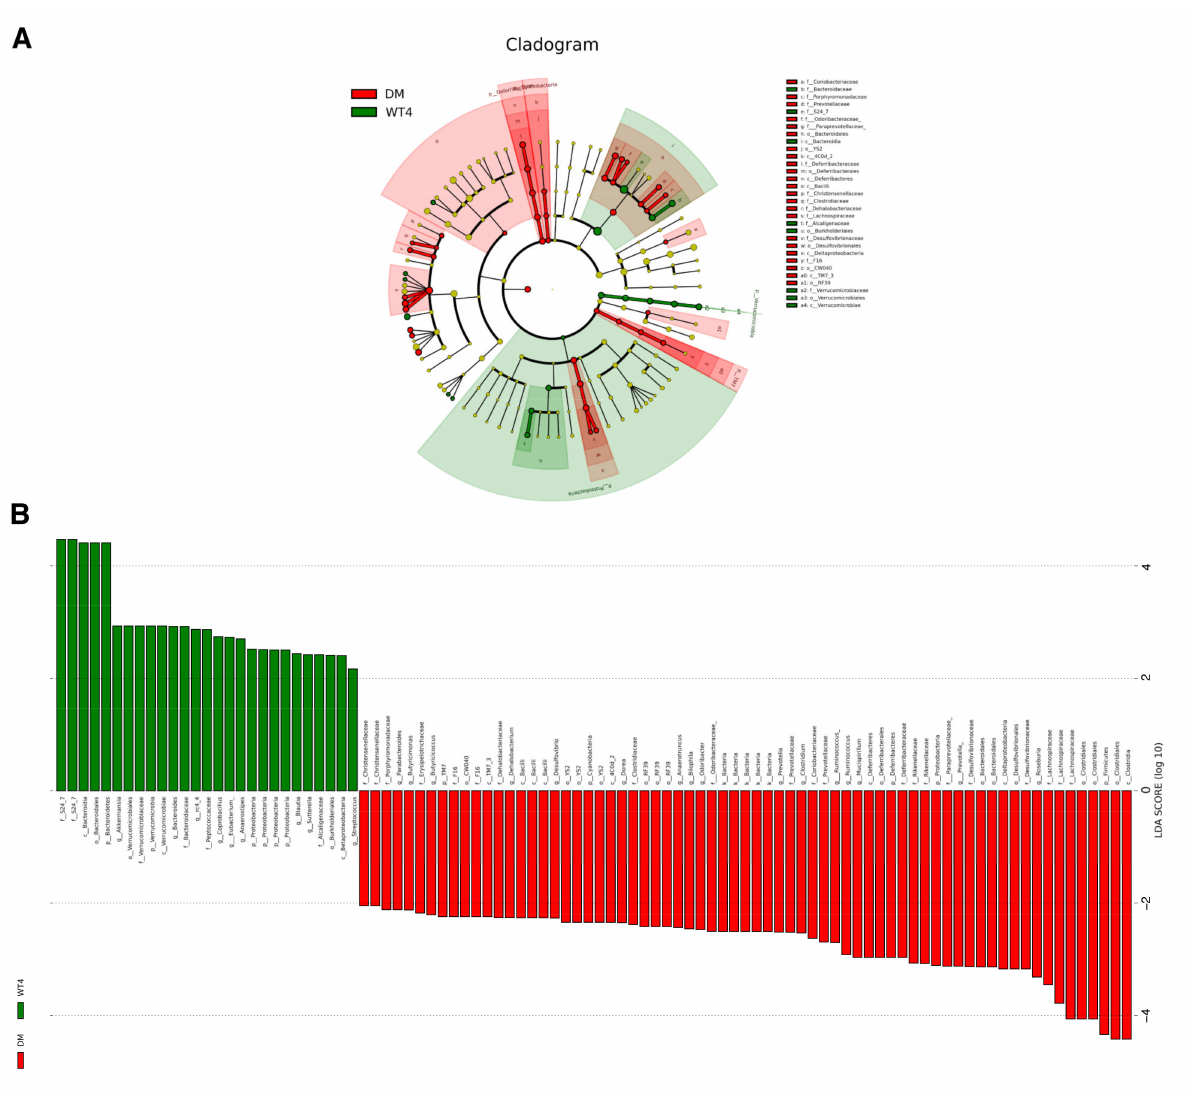
Figure 6. Taxonomic differences of fecal microbiota between db/db and WT mice. ( A ) A cladogram reporting the differences which were represented in the color of the most abundant class between the two groups of mice. Red indicates db/db mice, green wt mice, and yellow non-significant. The diameter of each circle is proportional to the relative taxon’s abundance. ( B ) The histogram of linear discriminant analysis (LDA) scores. The length of each bar represents the impact size of the bacterial taxa differentially